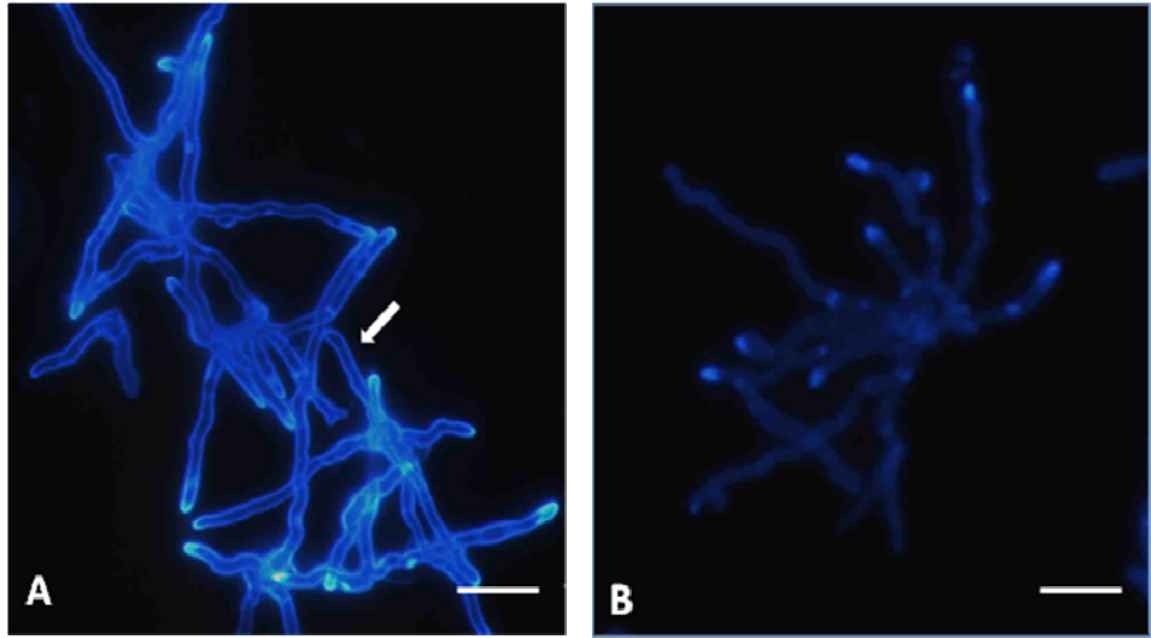
Figure 3 . Immunofluorescence microscopy showing hyphae of T. mentagrophytes stained by calcofluor white: (A) Control, arrows indicate intense labelling of the cell wall by calcofluor white; (B) Hyphae after treatment with TIO C 55  mol L -1 show weak labelling of the cell wall. Bars: 10 